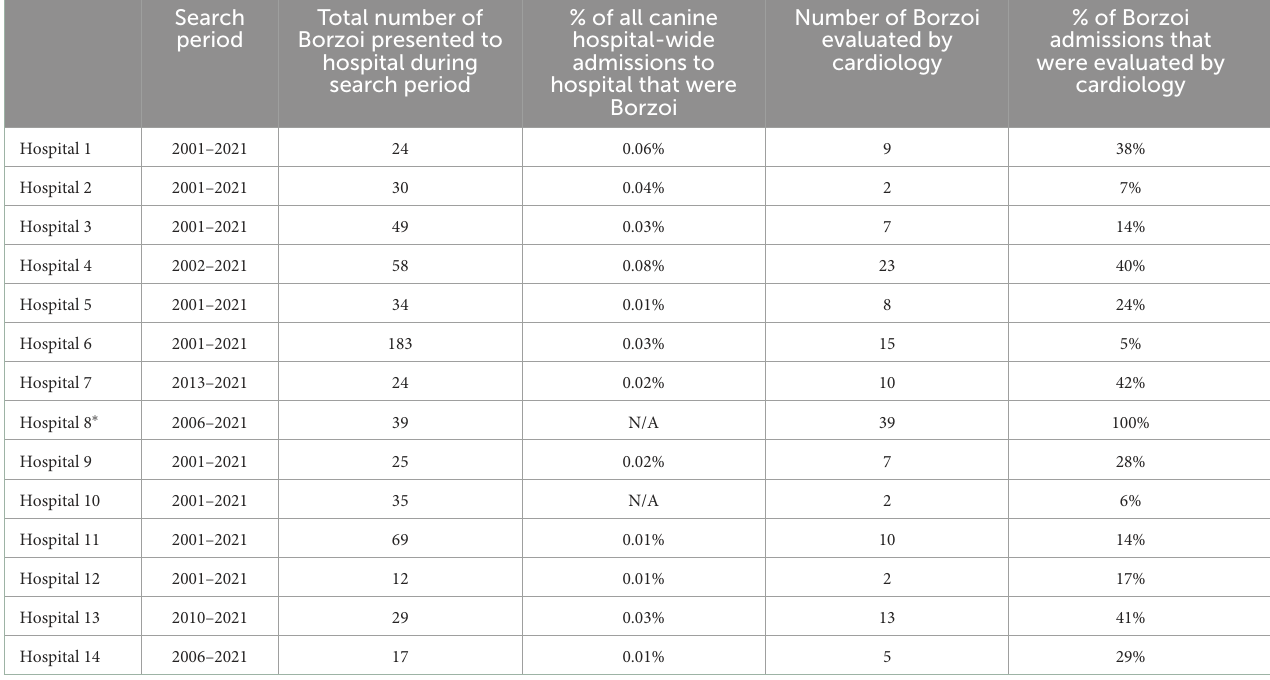
TABLE 1 Borzoi data from all participating sites over a maximum 20-year